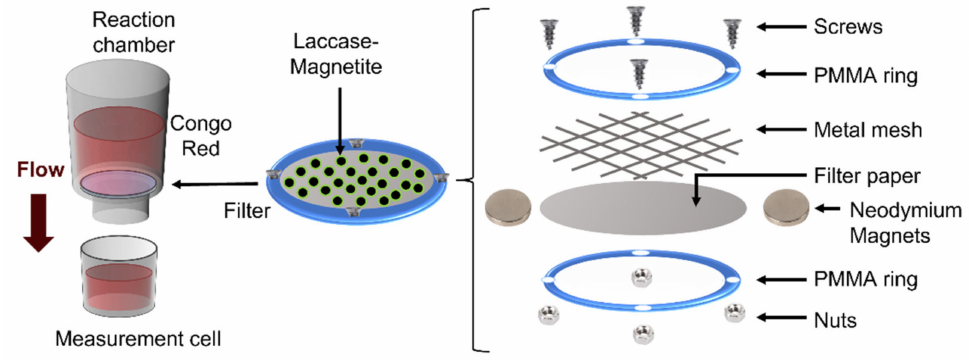
Figure 2. Filters schematic. The filters consisted of a reaction chamber and a measurement cell. The reaction chamber contained a paper-based biofilter with magnetite or magnetite with immobilized laccase molecules as biocatalysts and 50 mL volume of artificial